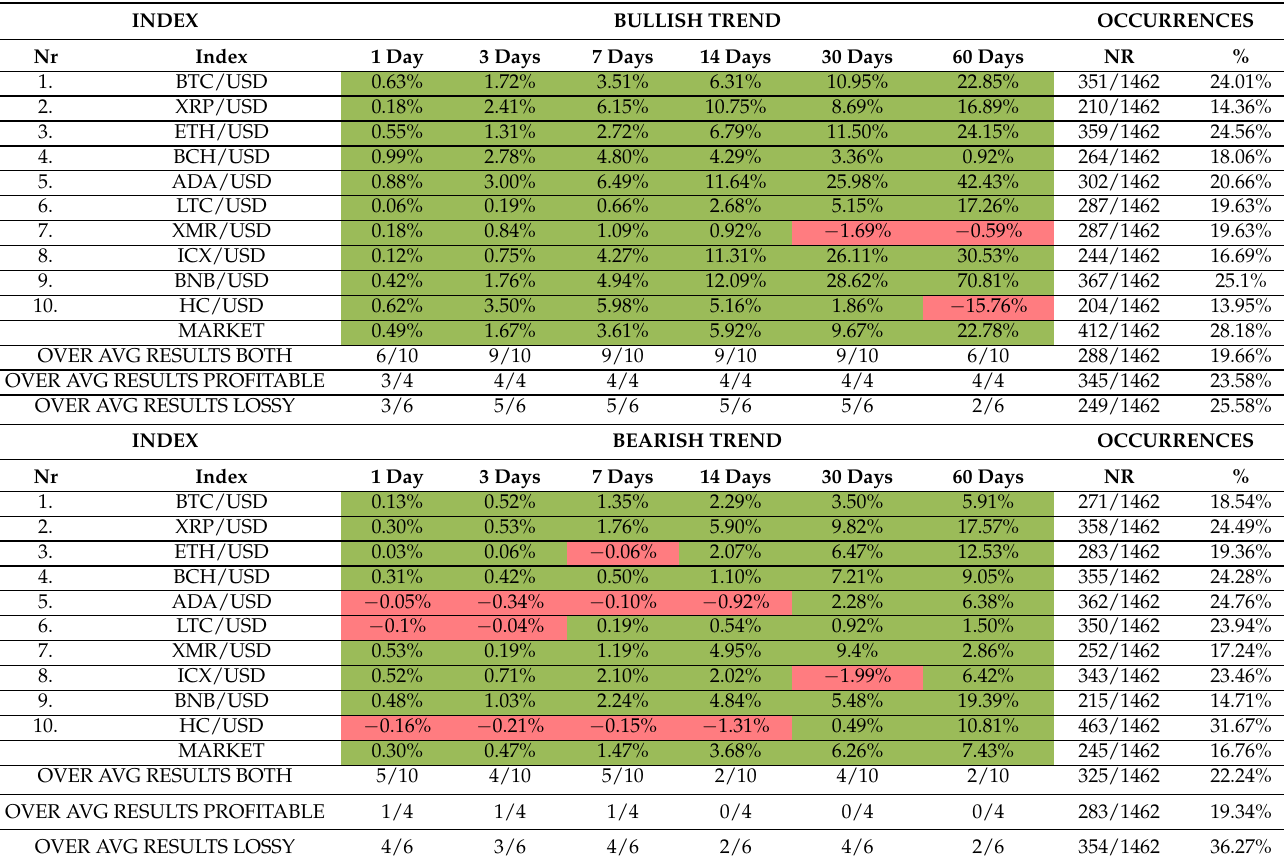
Table 6. Average returns of the examined cryptocurrencies after a selected number of days after the signal generated by the RSI application from the third experiment. In summary, the numbers indicate the number of indexes from a specific group that achieves above-average returns. Green indicates positive results, red indicates negative